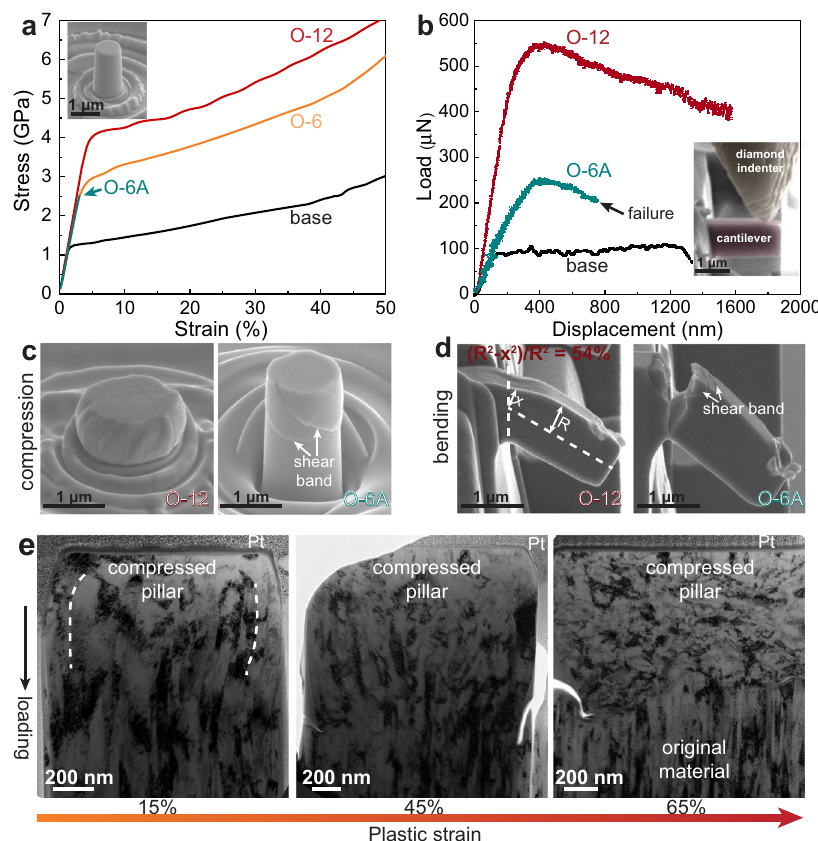
Fig. 3 Mechanical properties of the TiNbZr-O-C-N MISS alloys and the reference equiatomic TiNbZr base alloy. a Compressive engineering stress- strain curves of the base, O-6, O-6A, and O-12 alloys measured at ambient temperature. The curves are shown only up to 50% strain to clearly reveal the yield points (the compressive deformation of the O-6 and O-12 alloys is even higher, above a total strain of 65%). The inset in a shows the O-12 MISS alloy pillar prior to compression. The arrow in a indicates the onset of strain bursts in the amorphous O-6A alloy, due to shear banding, leading to early failure. b Load-displacement curves measured by bending of cantilever beams, fabricated from the base, O-6A, and O-12 alloys. The inset in b shows the position of the diamond indenter tool, deforming the O-12 cantilever. SEM images presenting c micro-pillars and d cantilevers of the O-12 and O-6A alloys after deformation. Some shear bands in the deformed O-6A amorphous alloy are indicated by the arrows in c and d , respectively. e TEM images revealing the grain structure evolution of the O-6 MISS alloy with increasing compressive strain. After ~15% strain, the originally columnar grains have become curved. As the strain increases to an intermediate deformation state of ~45%, both, curved columnar grains and newly formed sub-grains are found. With further increasing the strain to ~65%, the initially columnar nanograins have become